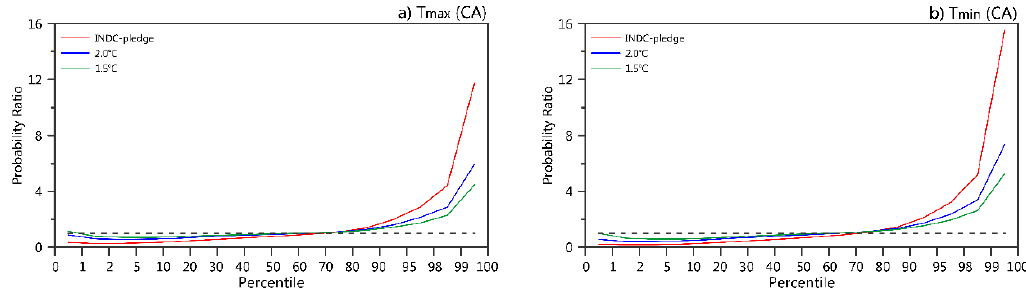
Figure 3. Regional mean probability ratio (PR) values over Central Asia for the responses of the daily maximum ( a ) and minimum ( b ) temperatures to the 1.5 ◦ C, 2.0 ◦ C, and ∆ T INDC global warming levels based on the percentile thresholds determined by the 1985–2005 climatology based on the multi-model ensemble mean. The dashed line represents a value of 1.0. The regional mean PR values for five subregions refer to Figure S2.